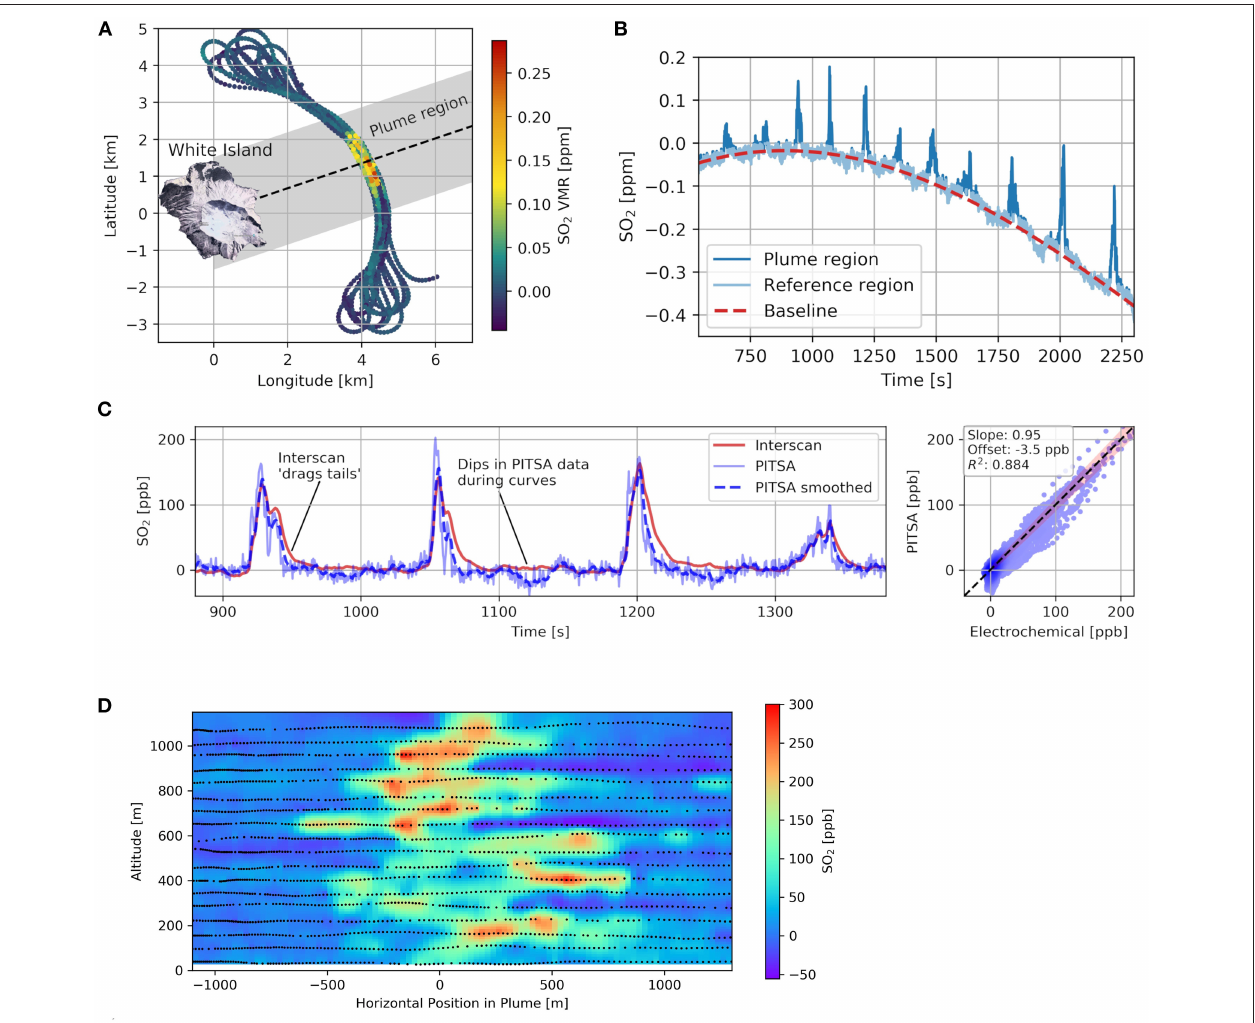
FIGURE 11 | Aircraft measurements at White Island volcano, New Zealand during December of 2015. (A) Flight path of the propeller machine, with respect to the position of the White Island crater. (B) Corresponding time series of the raw PITSA signal. The individual plume transects can be identified by the peaks on top of the baseline signal. The baseline was calculated by fitting a 4th order polynomial to the SO 2 free reference region. (C) Parallel measurements of the PITSA and the Interscan 4000 electrochemical sensor during the gas flight. The left plot shows an excerpt of the time series. After artificially degrading the PITSA’s response time, the two instruments are in good agreement when the plane penetrates the plume. When leaving again, there are large deviations, most likely due to an asymmetric response behavior of the Interscan. The scatter plot on the right shows 10s average values. Darkness of points represents the data point density. The red shaded area indicates the uncertainty of the Interscan as specified by the supplier. (D) The plume cross sectional SO 2 VMR, as measured by the PITSA. The map was interpolated from the actual sample points, which are represented by the small black